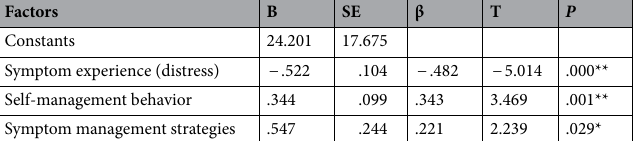
Table 4. The influencing factors of quality of life based on Symptom Management Model (N = 67) . F = 15.307**, R 2 =0.442, Cum R 2 =0.394 * p < .05, ** p <